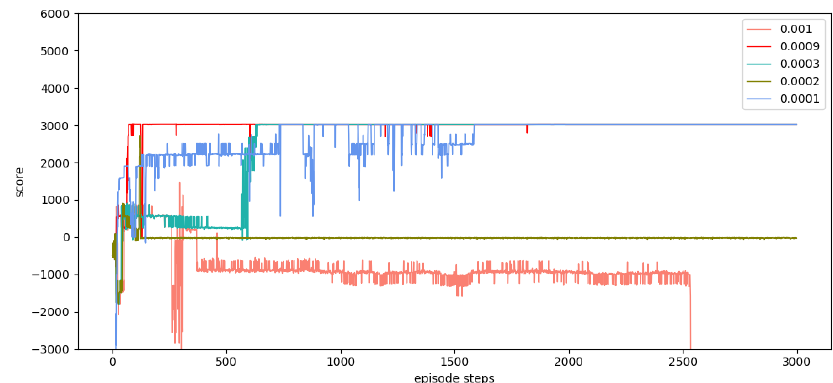
Figure 9. Training result of SD-TD3 (12) algorithm model in environment 1.